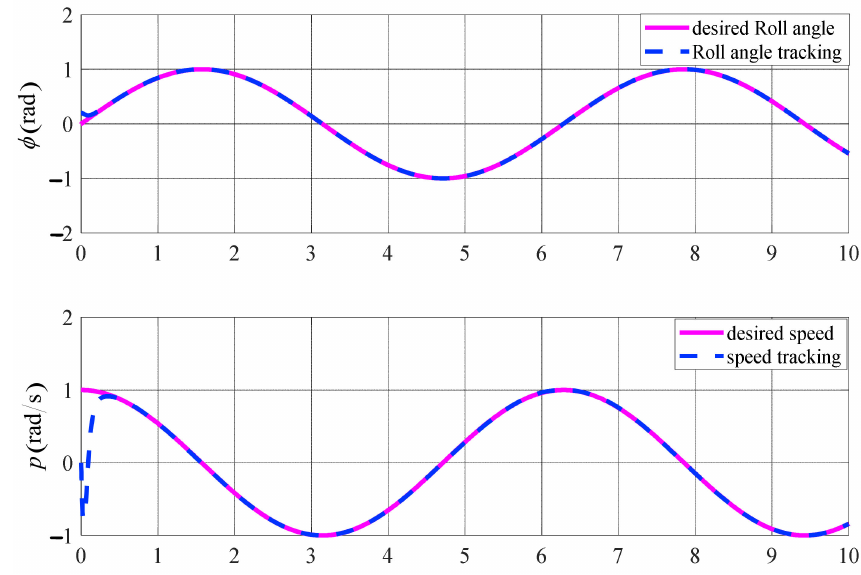
Figure 7. The performance of roll angle